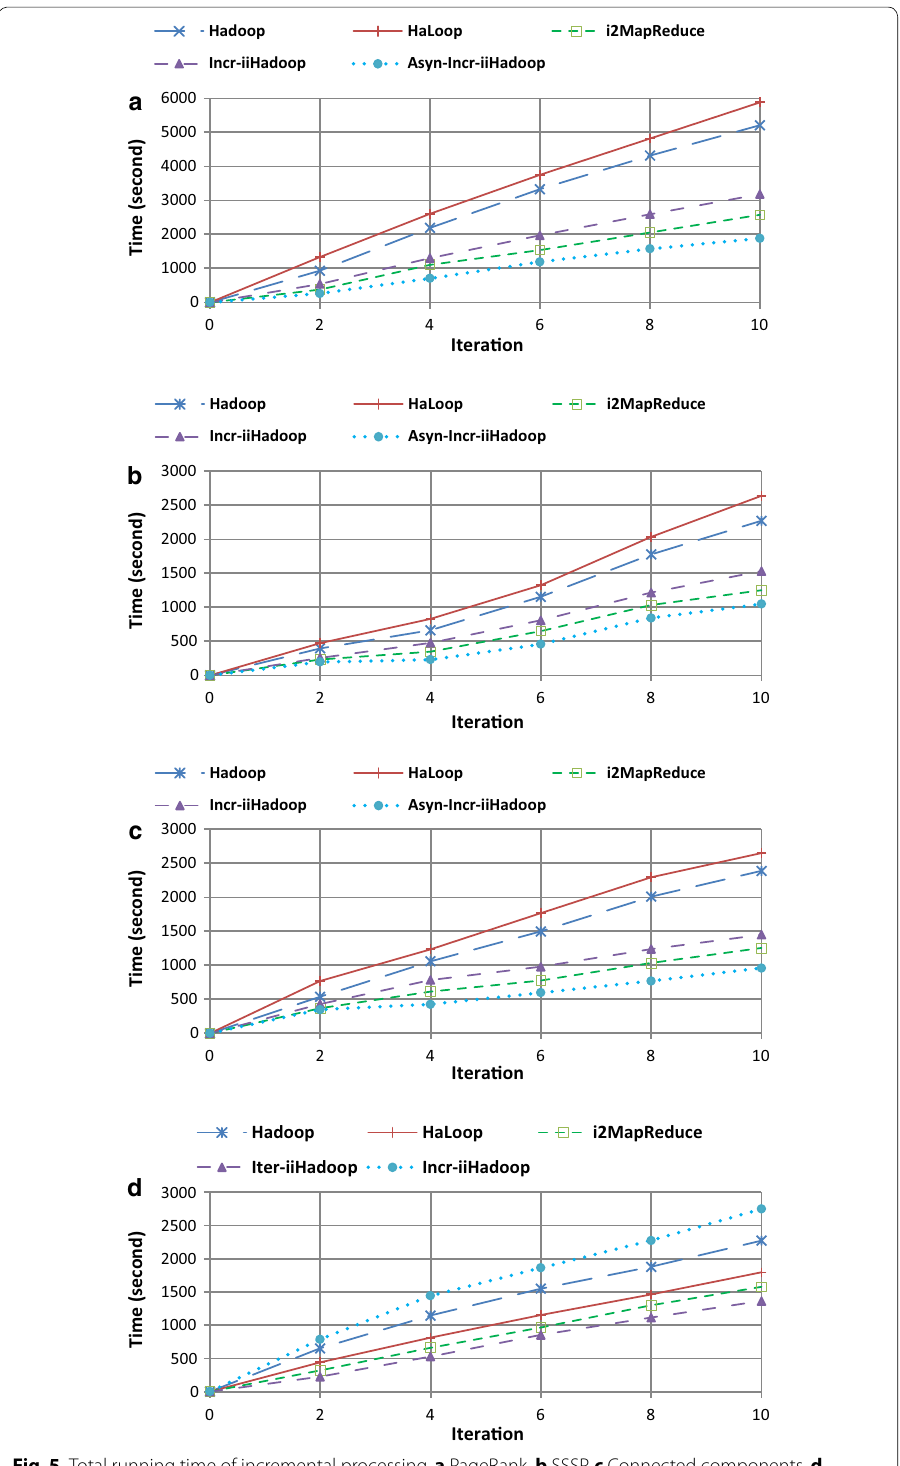
Fig. 5 Total running time of incremental processing. a PageRank. b SSSP. c Connected components. d